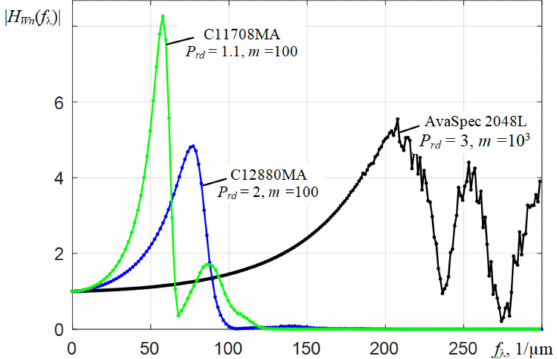
Figure 10. Transfer characteristics of the normalized Wiener filters | H Wn LEDR ( f λ )| for three spec- trometers using the Fourier transforms of the corresponding spectra of the red LED G LEDR ( ω λ ).